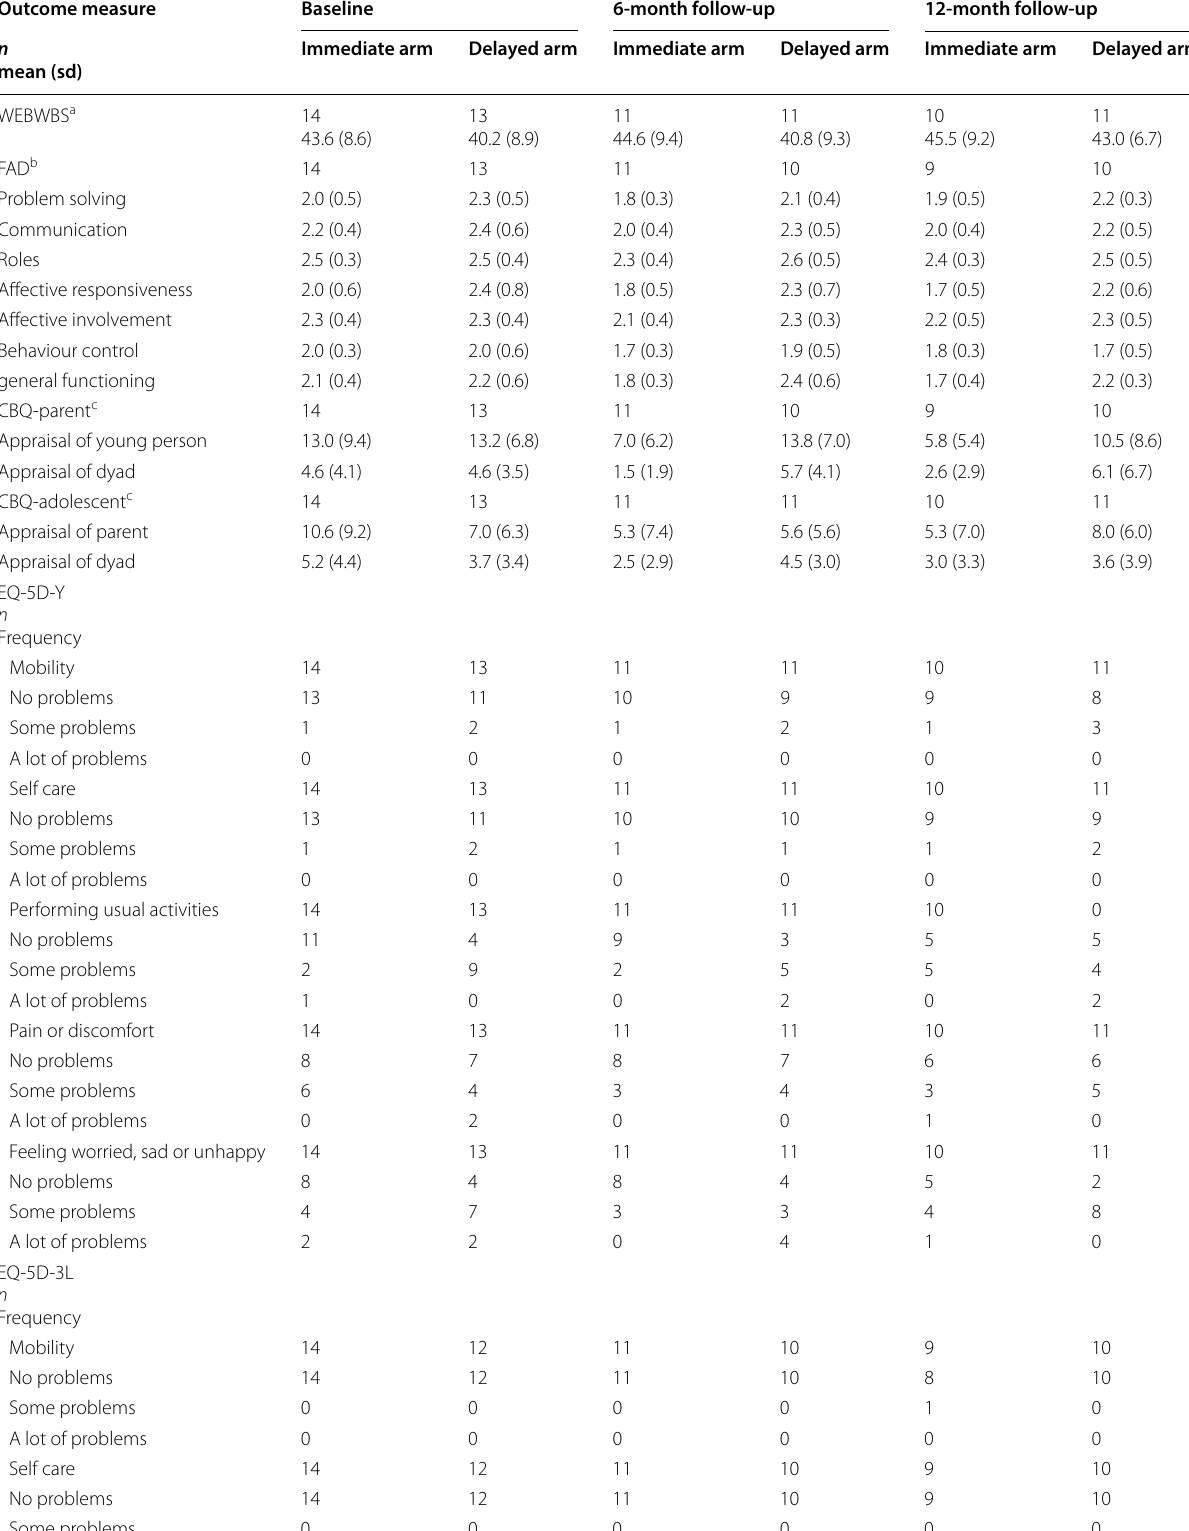
Table 2 Quantitative outcome measure summaries at each time point and by randomised arms Outcome measure Baseline 6-month follow-up 12-month follow-up n mean